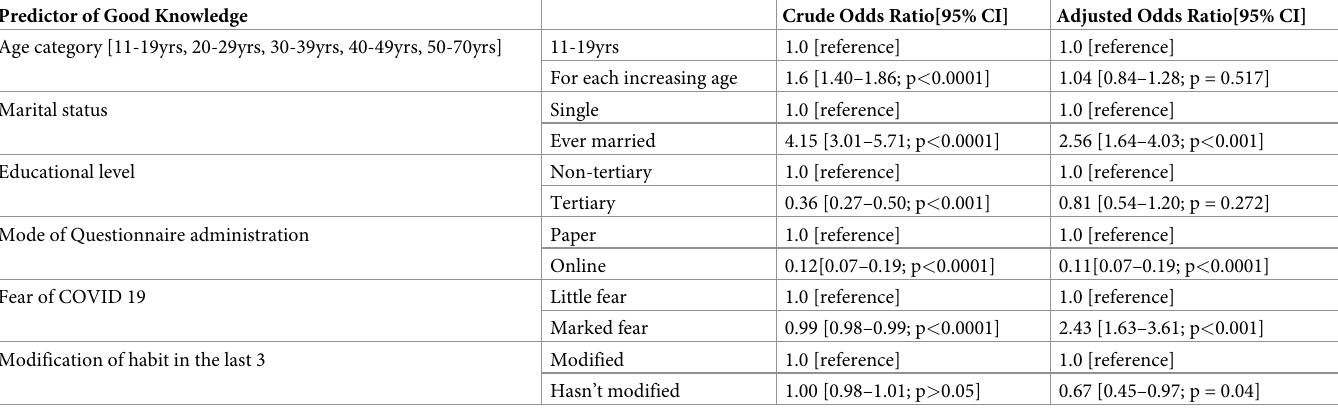
Table 4. Independent predictors of knowledge in multivariable logistic